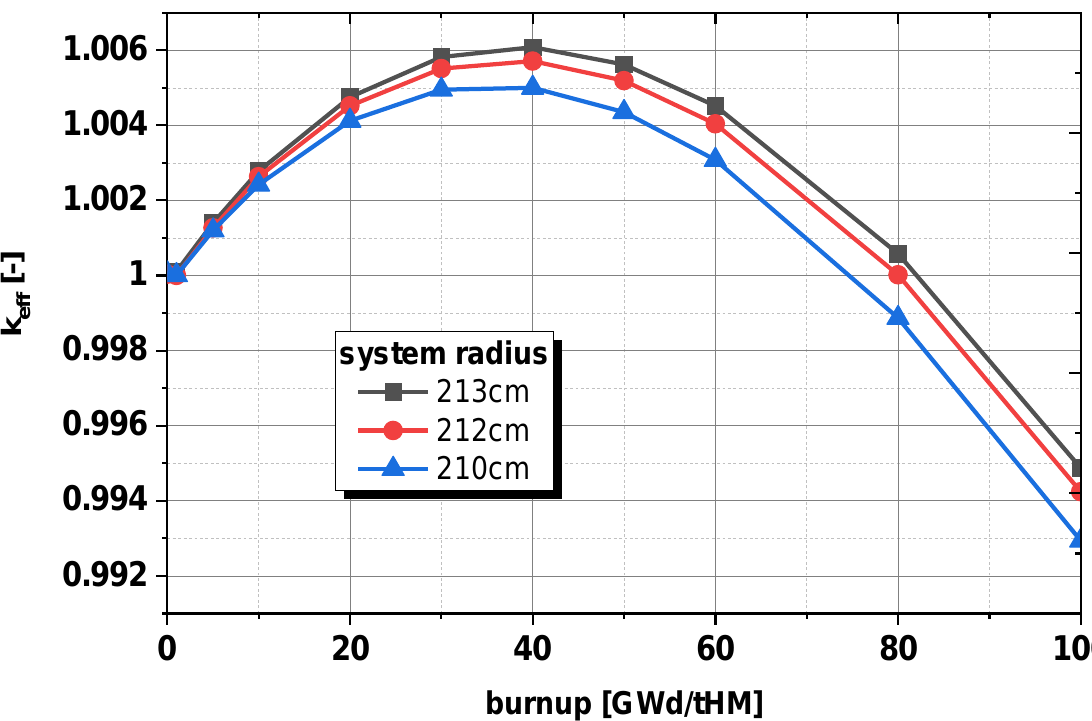
Figure 3. Criticality of the 2D finite system, as measured by k eff , as a function of burnup (time) for different system radii for the close to eutectic composition 45%NaCl–38.5%UCl 4 –16.5%UCl 3 .